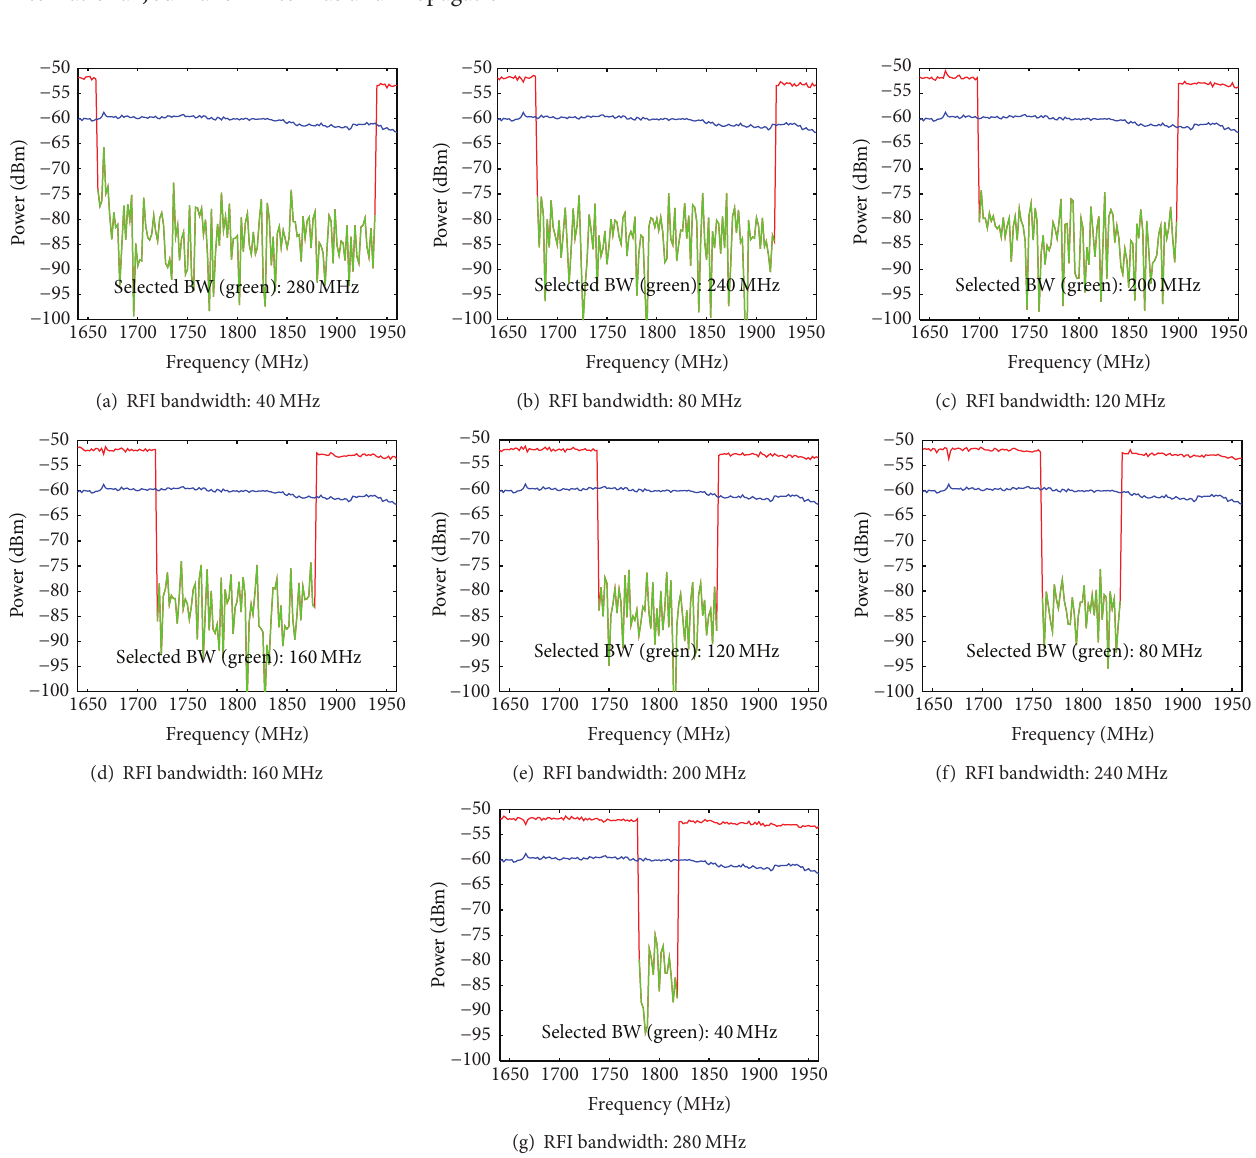
Figure 11: Power spectra of the wideband RFI. The blue line shows the target response (displayed for comparison with RFI). The red line shows the RFI. The green line is overlaid onto the red line and indicates the subband selected by